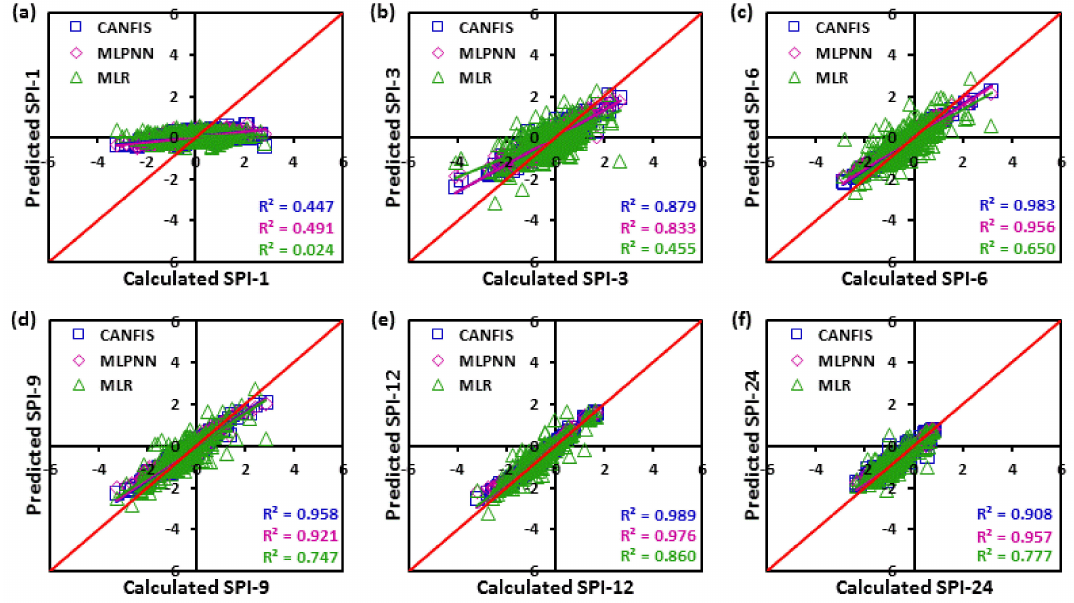
Figure 5. ( a – f ) Scatter plots of calculated and predicted multi-scalar SPI values by CANFIS, MLPNN, and MLR models during the testing period at Dehradun